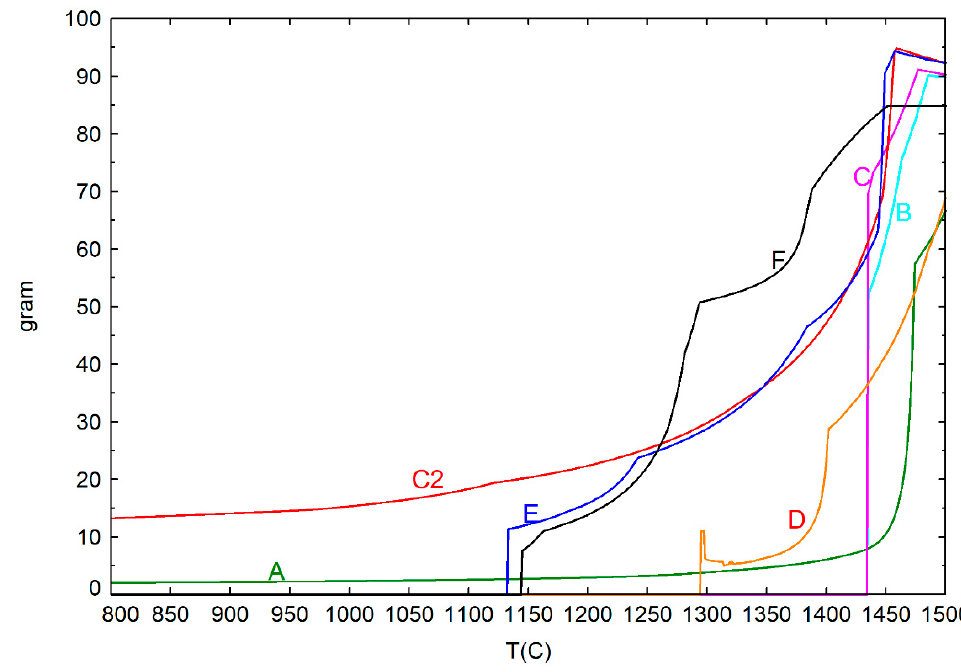
Figure 5. Simulation of liquid phase amount in considered research mixes.